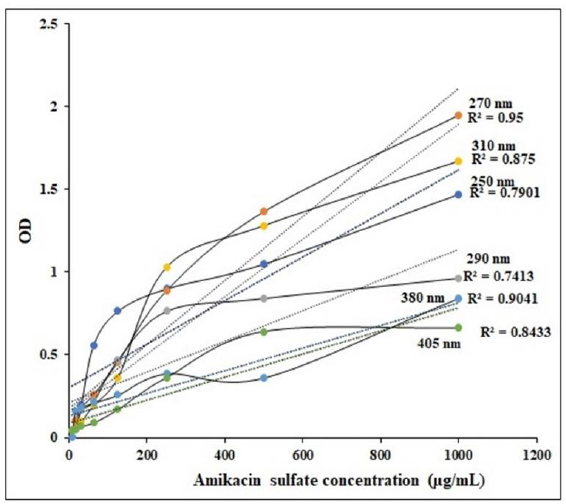
Figure 5. Standardization of Amikacin sulfate at various wavelengths .